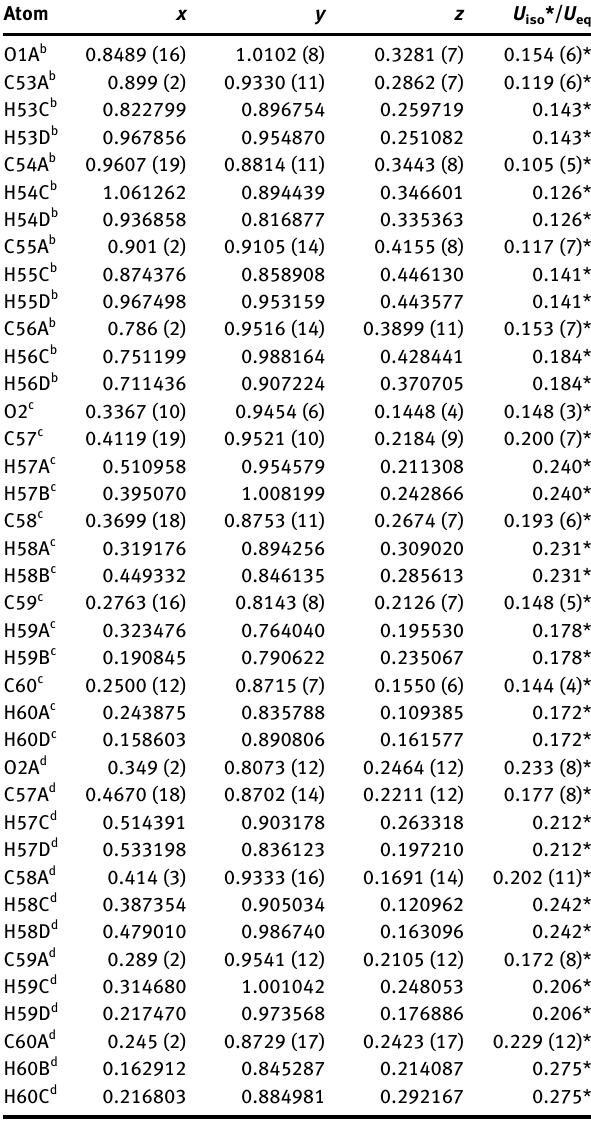
The molecular structure is shown in the figure (symmetry